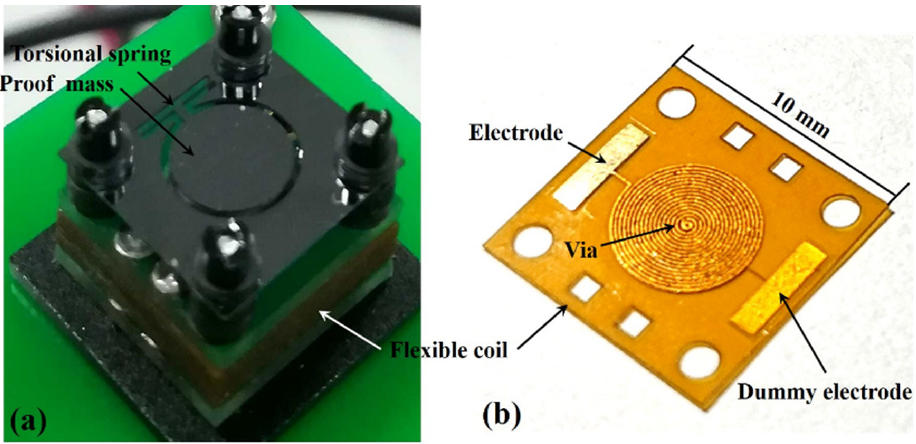
Figure 7. Photos of ( a ) assembled EVEH device (T1) and ( b ) a layer of the flexible